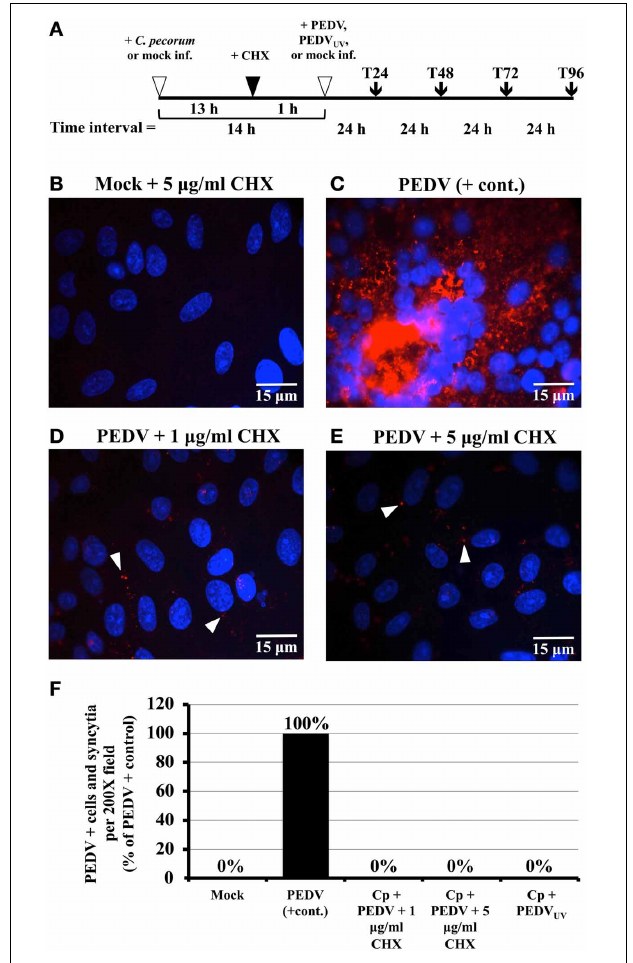
FIGURE 1 | Exposure to cycloheximide (CHX) and UV inactivation inhibits PEDV replication in Vero cells. (A) Simplified diagram of the co-infection procedure. At the start of each experiment, replicate Vero cell cultures on coverslips were either mock- or C. pecorum -infected. Fourteen hours later, they were mock-, PEDV- or PEDV UV -infected, as appropriate. In some experiments, cells were CHX-exposed from 1h prior to viral infection to the end of the experiment. Regardless, all cells were refed with fresh growth medium ( + or − CHX as appropriate) after PEDV infection (T0). Samples were harvested for various analyses at 24 (T24), 48 (T48), 72 (T72) or 96 (T96) hpvi. (B–E) Vero cells were pre-exposed to either 1 μ g/ml CHX or 5 μ g/ml CHX, as indicated. One hour later, cultures were either PEDV-infected (PEDV) or mock-infected (Mock). Cultures were incubated for 48 hpvi, fixed, and immunolabeled with anti-PEDVM (red) and DAPI (blue). Representative fields at 1000 × magnification are shown with 15 μ m scale bars. White arrows indicate anti-PEDVM punctate staining, as discussed in the text. (F) Vero cells were mock-infected (Mock), mono-infected with PEDV (PEDV + cont.), infected with C. pecorum and PEDV (Cp + PEDV), or infected with C. pecorum and PEDV UV (Cp + PEDV UV ) as in (A) . In some cases, the cells were pre-exposed to 1 μ g/ml CHX or 5 μ g/ml CHX, as indicated. At 24 hpvi, cells were fixed, and labeled with anti-PEDVM (red) and DAPI (blue). Twenty random 200 × magnification fields were examined on each coverslip; PEDVM protein positive single cells and syncytia were counted for each field, added together, and the average total number/field calculated. The PEDV positive control was set at 100% and the average counts obtained for the other samples were used to calculate % of the positive control. The % positive control values obtained were then plotted on the Y-axis; sample identity is shown below the